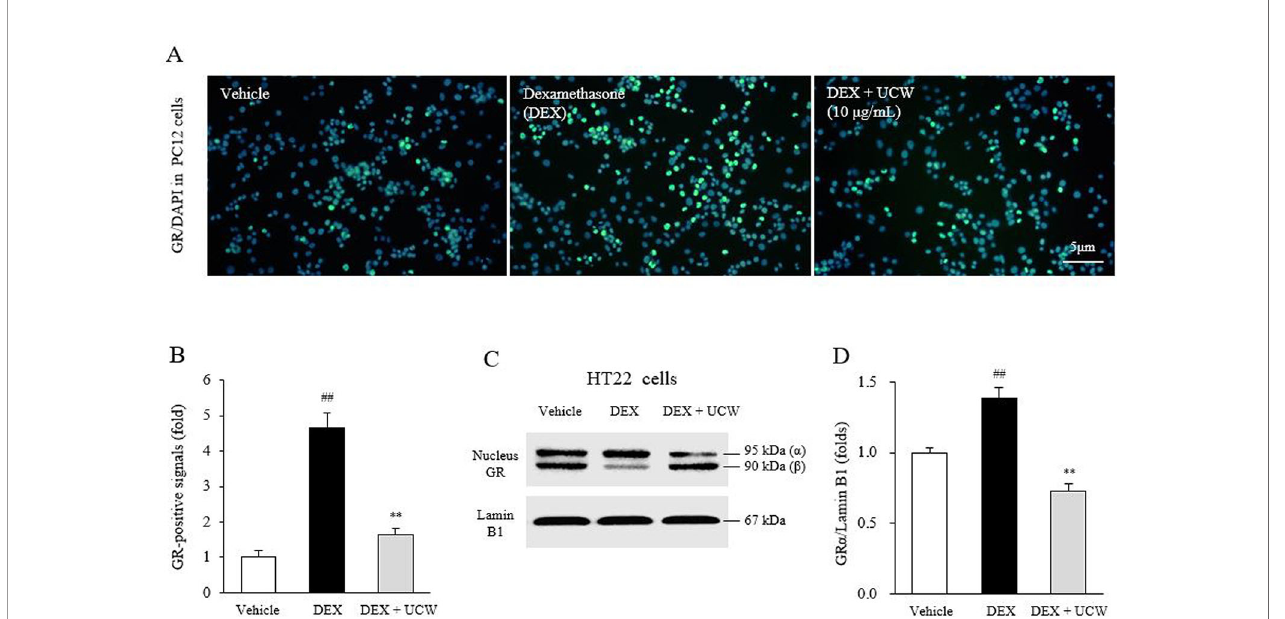
FIGURE 3 | Effects of UCW on the GR in relative intensity in PC12 cells and HT22 cells. Immuno fl uorescence of GR in nucleus of PC12 cells (A) and its semi- quantity (B) were conducted under dexamethasone treated condition. The nuclear translocation of GR a isoform was also determined by Western blotting in HT22 cells (C) and its semi-quantity (D) . Data are presented as the mean ± SD (n = 3). ## P < 0.01 compared with the vehicle-treated cells; **P < 0.01 compared with the dexamethasone-treated